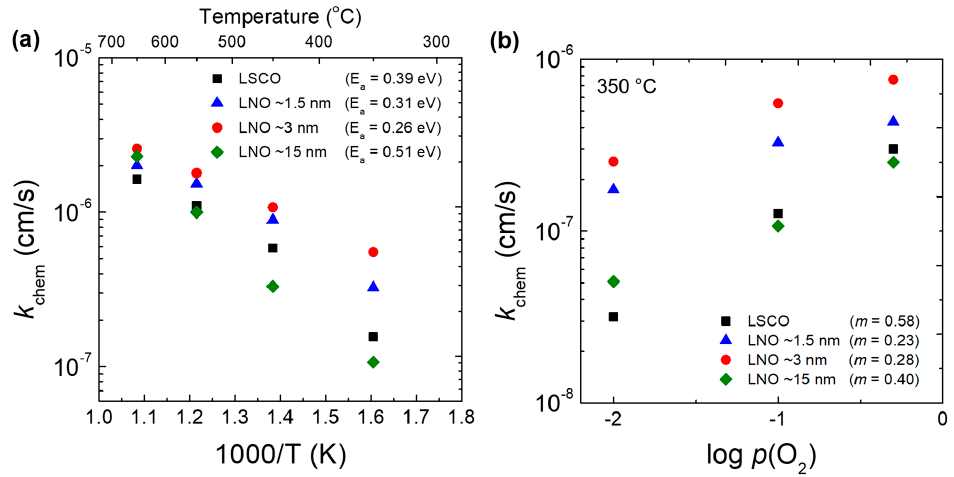
Figure 3. ( a ) Temperature and ( b ) p (O 2 )-dependent k chem values for undecorated LSCO and LNO- decorated LSCO